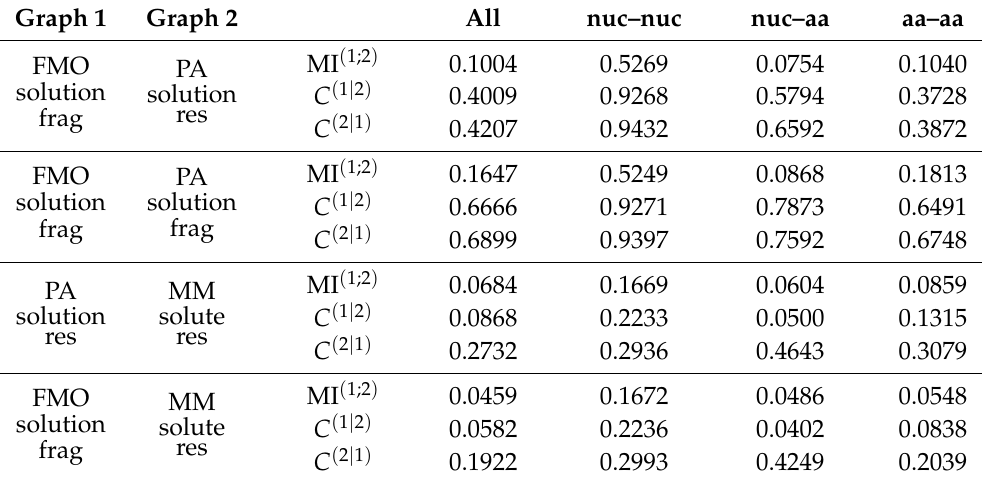
Table 8. Mutual information (MI) and coefficients of constraint C between two different interaction graphs ( ∆ E ij ), labeled by 1 and 2 a